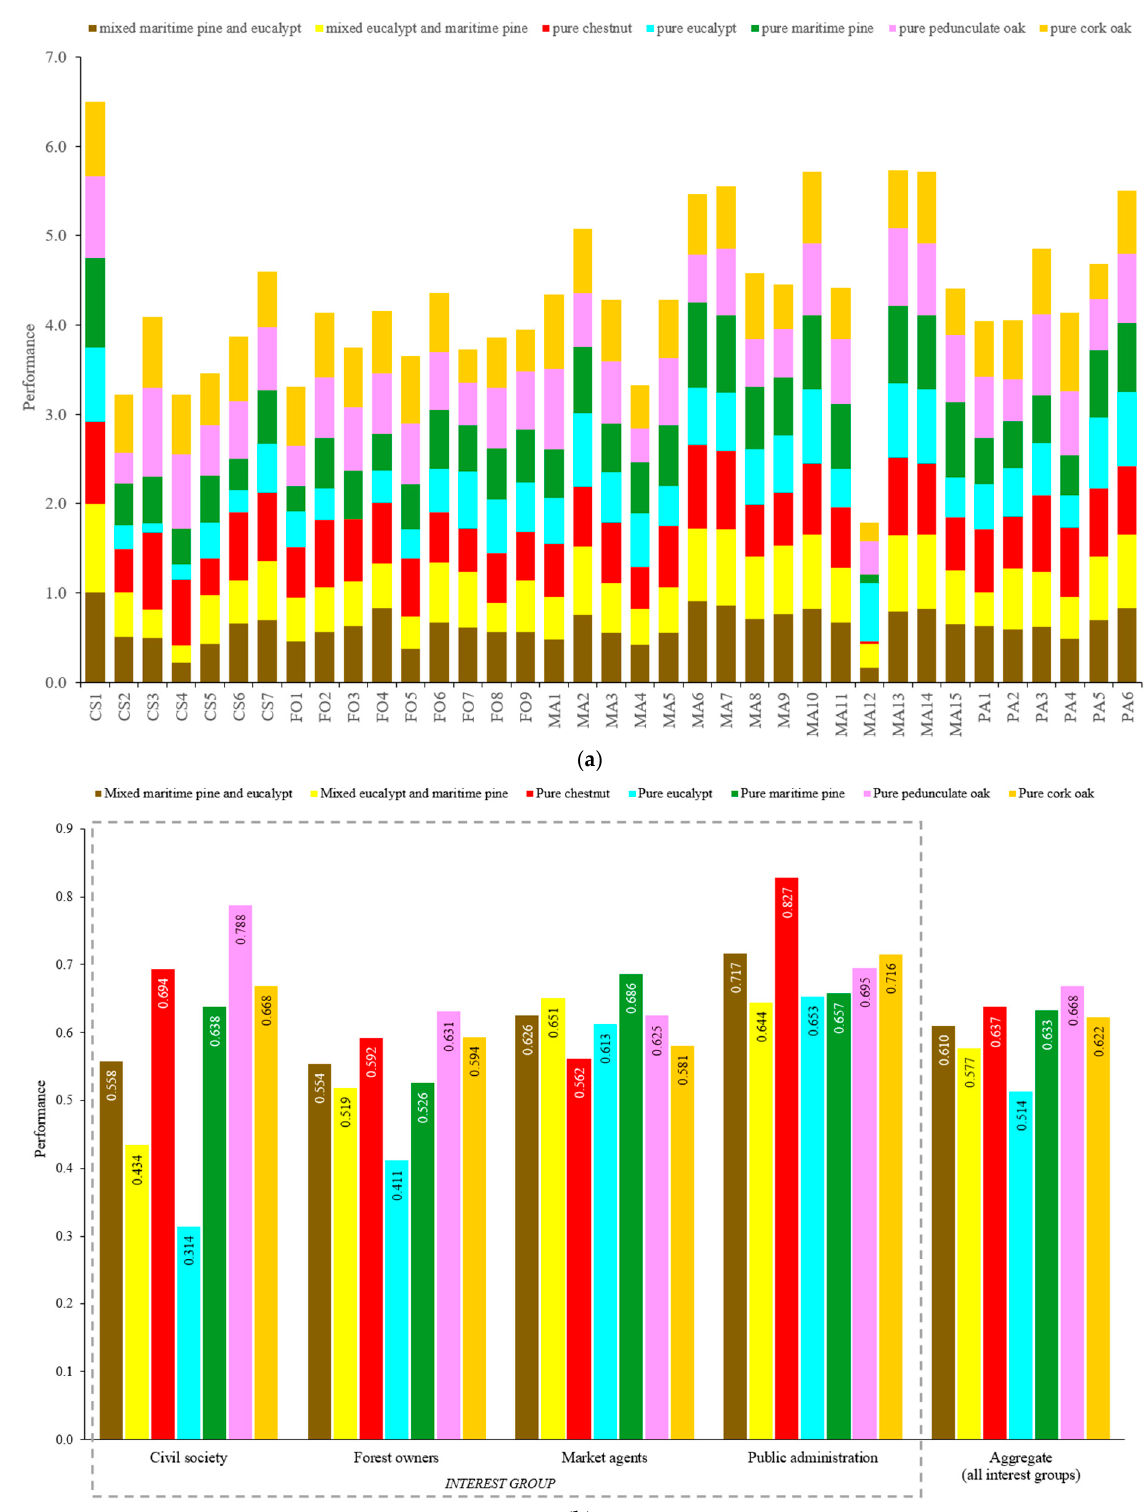
Figure 10. Performance of alternatives: ( a ) Performance according to each actor; ( b ) Performance aggregated by interest group and aggregated across all interest groups. We calculated the SMART utility score for each attribute of the alternative FMM as the median response of the actors in the group. The group-weighted CDP utility score for each FMM was calculated with Equation (1).